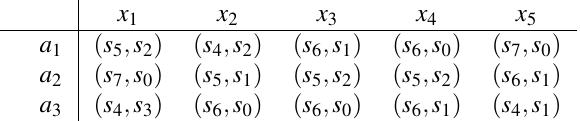
Table 6. Decision matrix R 2